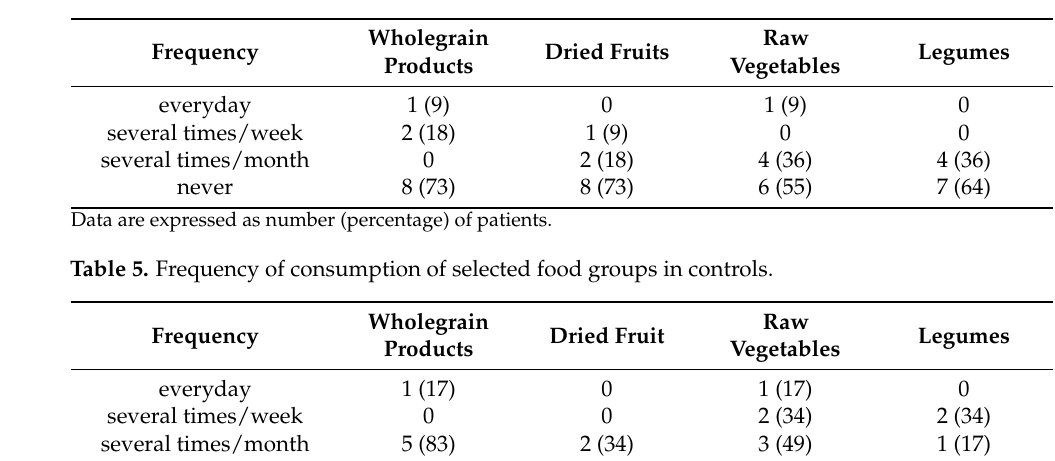
Table 4. Frequency of consumption of selected food groups in patients with inactive IBD.